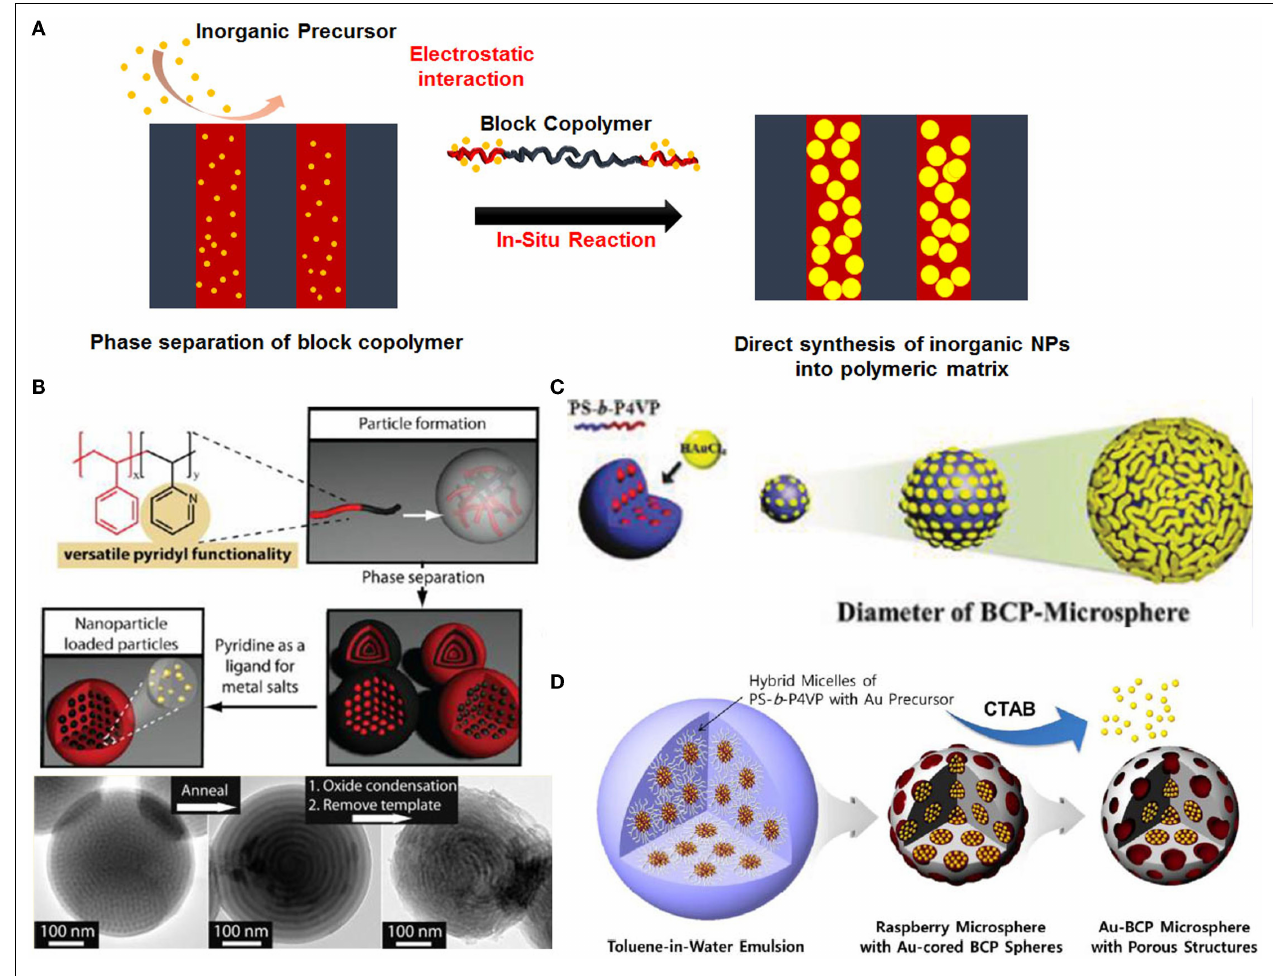
of Au-decorated PS- b -P4VP particles with controlled surface nanostructures from dot-pattern to fingerprint-pattern (Kim et al., 2012). (D) Schematic illustration of hybrid PS- b -P4VP particles with controlled porous surface nanostructures (Kim et al.,